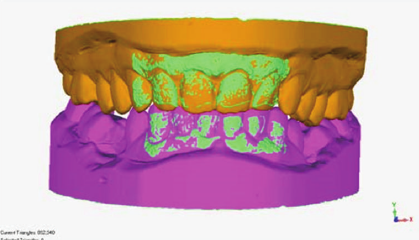
Figure 7: The registration of complete upper and lower 3D